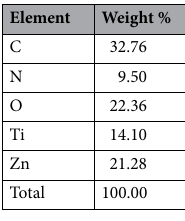
Table 3. Percentage of elements in T1 ‒ Z1/CS1 ‒ Gr2.